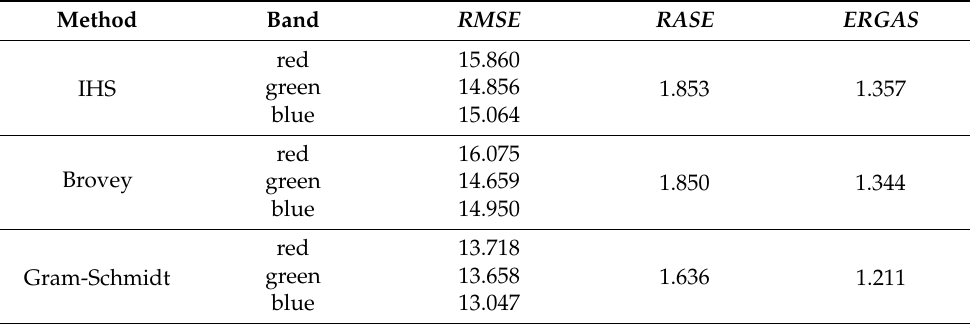
Table 2. Quality indexes obtained from WV-2